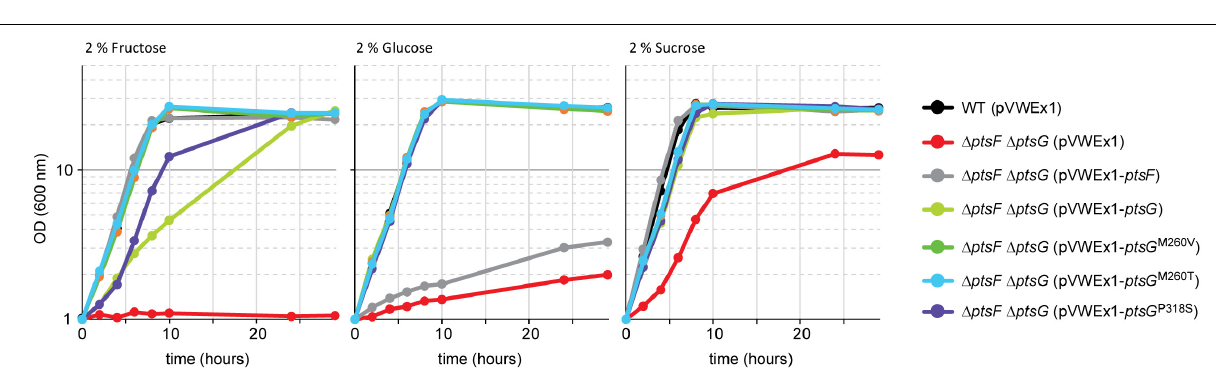
Frontiers in Bioengineering and Biotechnology |